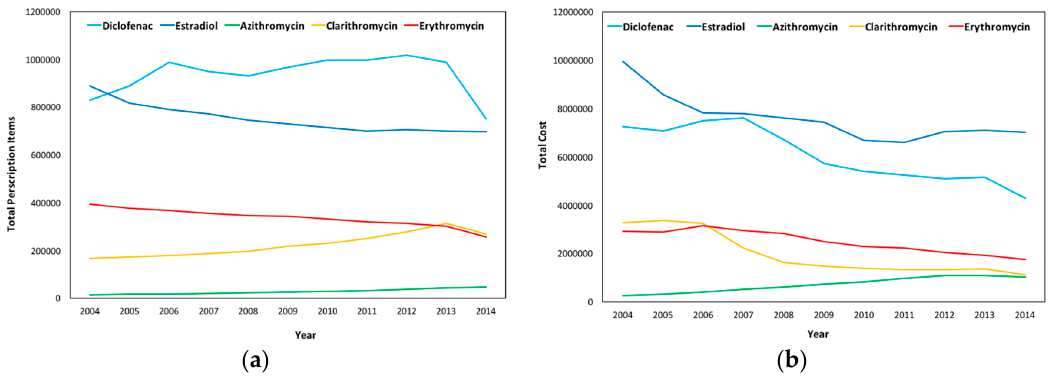
Figure 10. Scotland’s Total ( a ) Prescription Items and ( b ) Cost (£) per substance from 2004 to 2014.